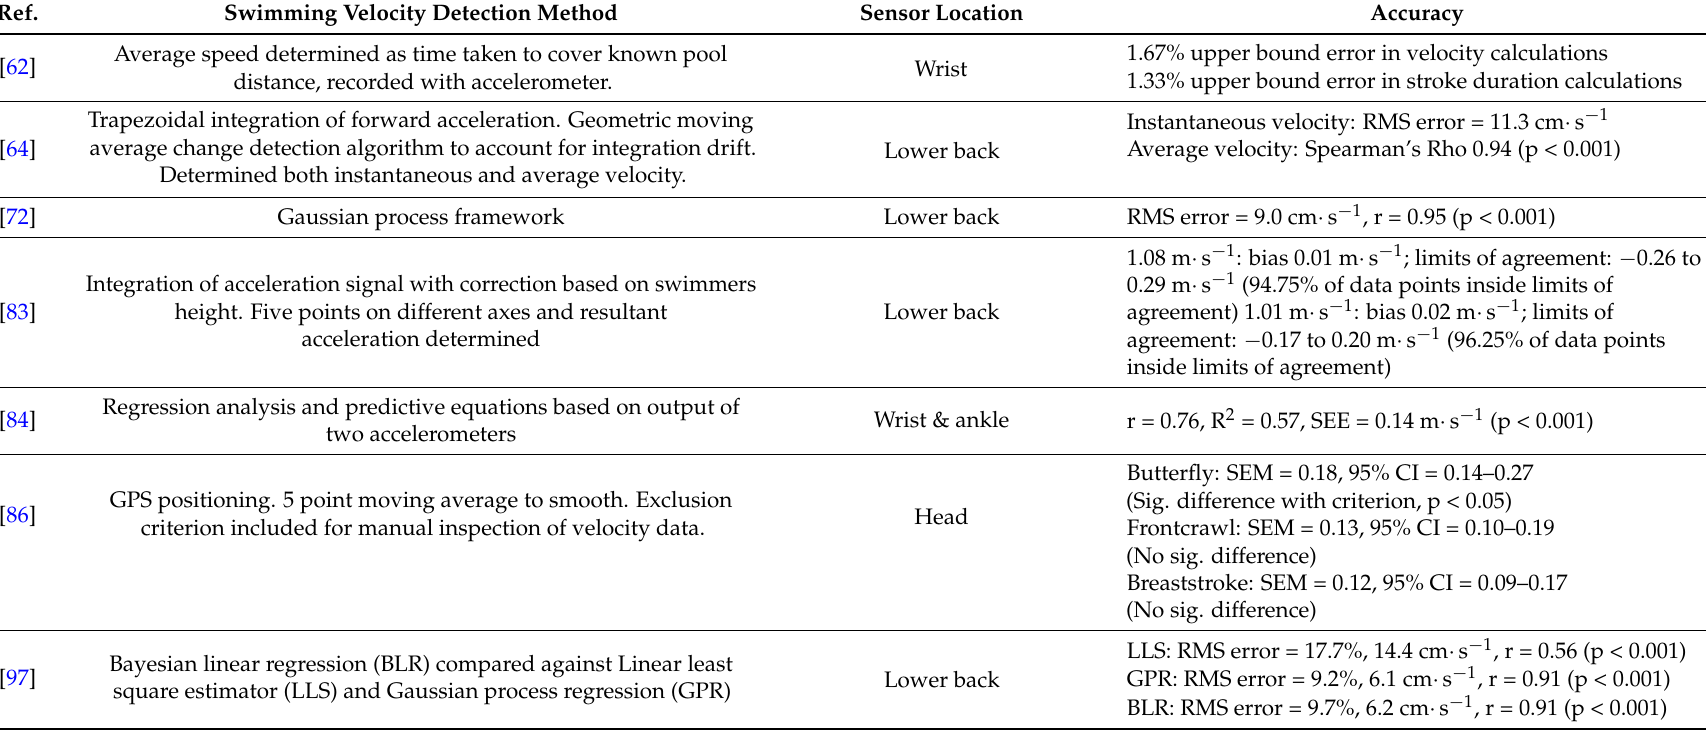
Table 5. Details of various methods used for the detection of swimming velocity using inertial sensor devices and reported detection accuracy. Ref. Average speed determined as time taken to cover known pool Trapezoidal integration of forward acceleration. Geometric moving average change detection algorithm to account for integration drift. [64]